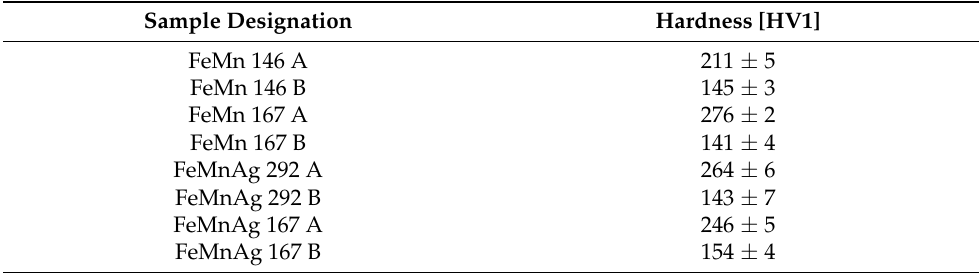
Figure 5. Presentation of ε -martensite: ( a ) dilatometry curve with marked same temperature of transformation during heating and cooling; ( b ) inverse pole figure in Z direction (IPF-Z) where the diversity of ε -martensite and γ -austenite orientation is presented; ( c ) ratio between γ -austenite and ε -martensite with specific type of needle formation. Table 4. Hardness values for SLM